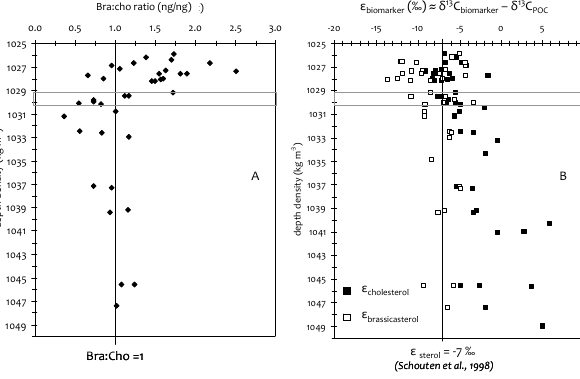
Fig. 4. (A) =vertical profile of small particle brassicasterol vs. cholesterol concentration ratio (ngng − 1 ; from Supplement An- nex 1) for the whole dataset. (B) =vertical profile of ε cholesterol and ε brassicasterol for the whole dataset ( ε sterol (‰) = δ 13 C sterol – δ 13 C SP-POC ) ; standard error propagation range between 1.1 and 1.8‰. For each panel, the space located between the two horizontal lines represents the range of 500m depth horizons along the tran-